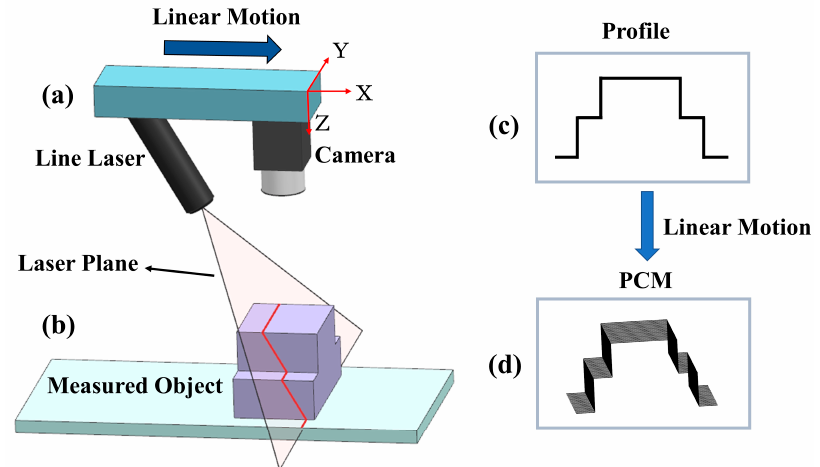
Figure 2. The principle of 3D laser vision. ( a ) The measurement module comprising the camera and the laser; ( b ) The laser line on the measured object located on the laser plane; ( c ) The single point-cloud profile obtained by the calculation using Equations (1) and (2); ( d ) The PCM formed with a series of point-cloud profiles schemed as in ( c ).